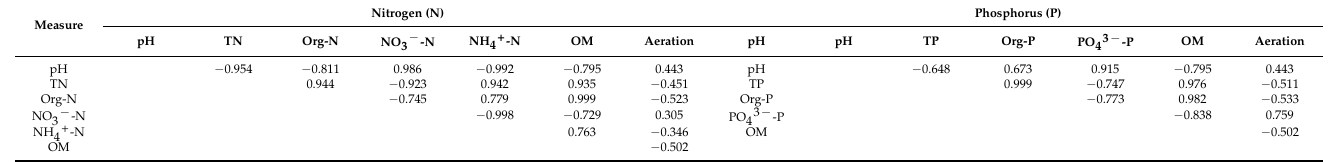
Table 6. Pearson’s correlation coefficients across types of N and P, pH, and OM in slurry